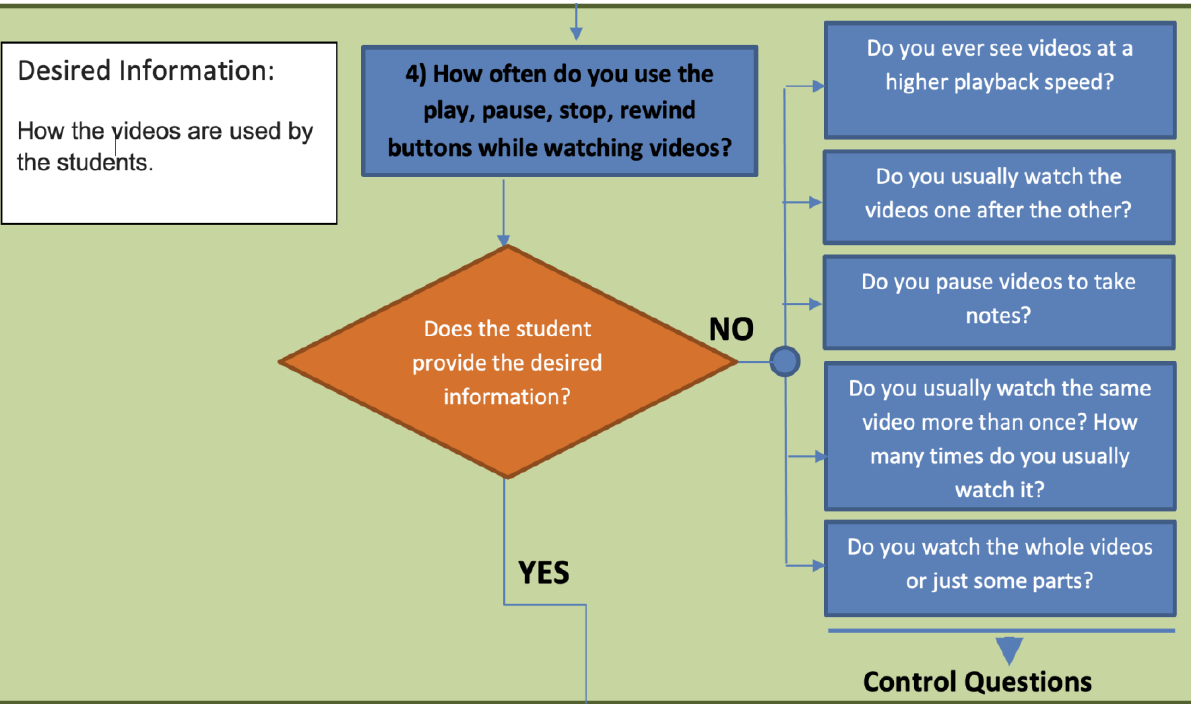
Figure A5. Structure of the interview (V).